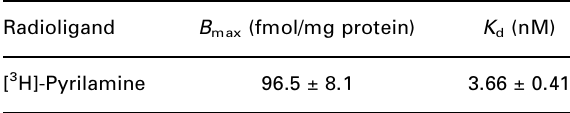
Table 1. Specific [ 3 H]-Pyrilamine binding to submandibular gland membranes